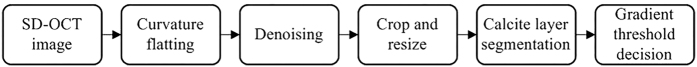
The generalized algorithm schematic.